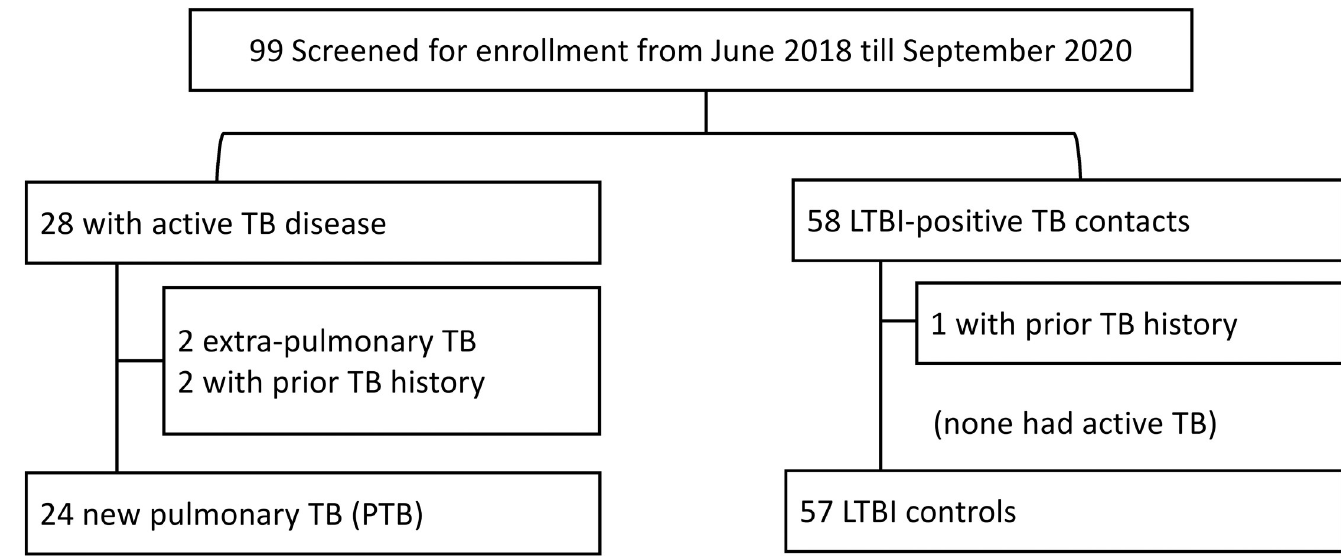
Fig 1. Flowchart of participant enrollment. Abbreviations: LTBI, latent tuberculosis (TB) infection.